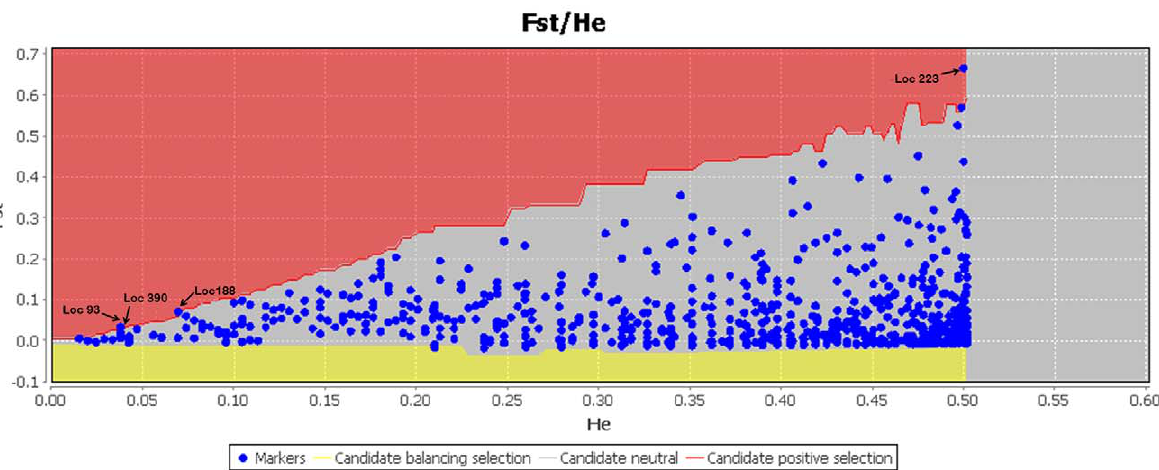
Figure 3. Result of Dfdist analyses in Mcheza. F ST against heterozygosity plot is provided. Loci were identified as significant, corresponding to a 99% critical frequency and 99.5% confidence interval. Red and yellow lines represent 0.995th and 0.005th quantiles of the conditional distribution obtained from Dfdist simulations respectively. Each blue dot indicates AFLP marker; dots in gray areas represent neutral loci falling below the 0.995 quantile’s broad line, whereas outlier loci in red areas are pointed out by arrows and accompanied by the locus number.